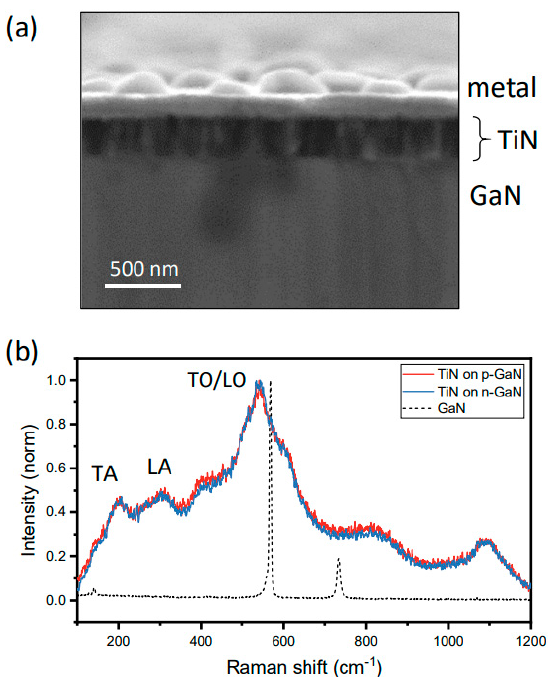
Figure 1. Structural characterization. Cross-sectional SEM shown in ( a ) reveals columnar microstruc- ture of TiN film and thickness of ~200 nm. Raman scattering spectra ( b ) of TiN grown on p- and n-GaN (red and blue) show virtually identical features attributed to dominant optical phonons ~540 cm − 1 and acoustic phonons ~300 cm − 1 and below. The response of the GaN substrate is shown as a dashed curve. The structural quality of the TiN film was also evaluated by Raman scattering spec- troscopy (Figure 1b). In these spectra (red and blue curves correspond to p- and n-GaN, respectively), signature peaks are visible and correspond to low-frequency acoustic phonon modes (TA and LA located at ~200 and 300 cm − 1 ) as well optical phonon modes near 540 cm − 1 [32]. We also observed combination modes ~410 and 800 cm − 1 . Most important to the work presented here are three points. First, the clear observation of these peaks indicates reasonable crystallinity. Secondly, the positions of the acoustic phonon features at 200 and 300 cm − 1 and the LO/TO feature at ~540 cm − 1 are all consistent with low N vacancy concentrations (~0.5%) [33]. Lastly, the relatively strong intensity of the TO/LO peak has been associated with Ti vacancies which can arise due to Ti oxidation [34]. Even though we do not present direct measure of Ti oxidation levels, it is reasonable to expect Ti, a strong oxygen getterer, to exhibit some level of unintended oxidation. We have also presented the Raman scattering response of the bare GaN substrate (dashed curve in Figure 1b) simply to show that no peaks in the TiN spectra can be attributed to the underly- ing GaN